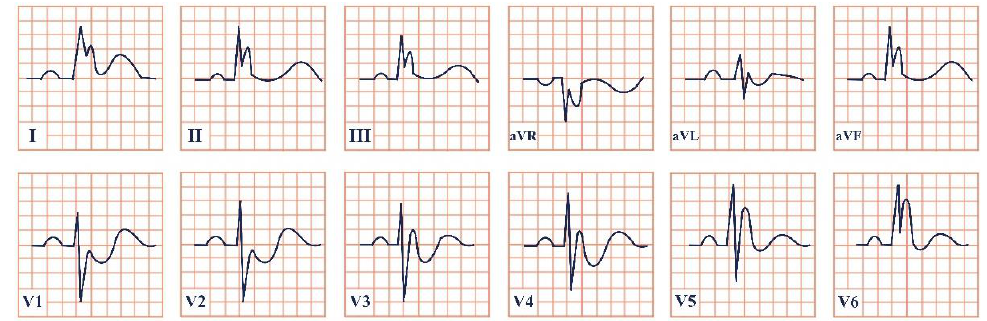
Figure 12. Electrocardiogram aspect in Osborn syndrome.